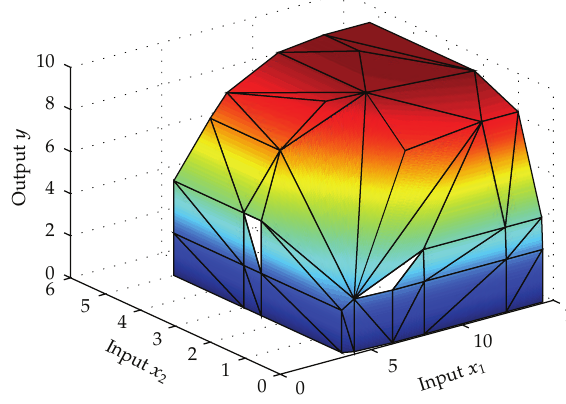
Figure 9: E ffi cient hull, VRS.